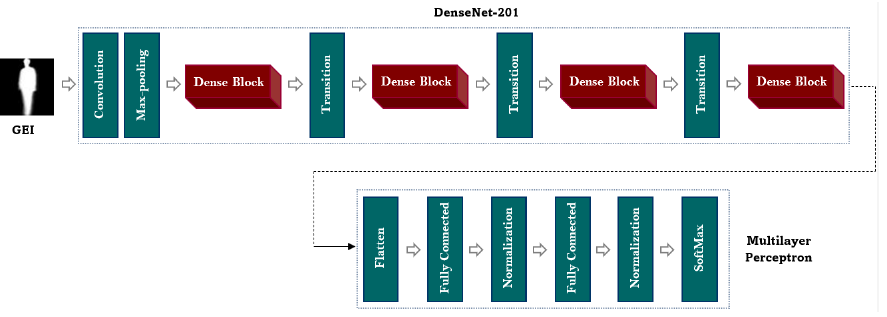
Figure 3. Architecture of the DenseNet-201 with the Multilayer Perceptron